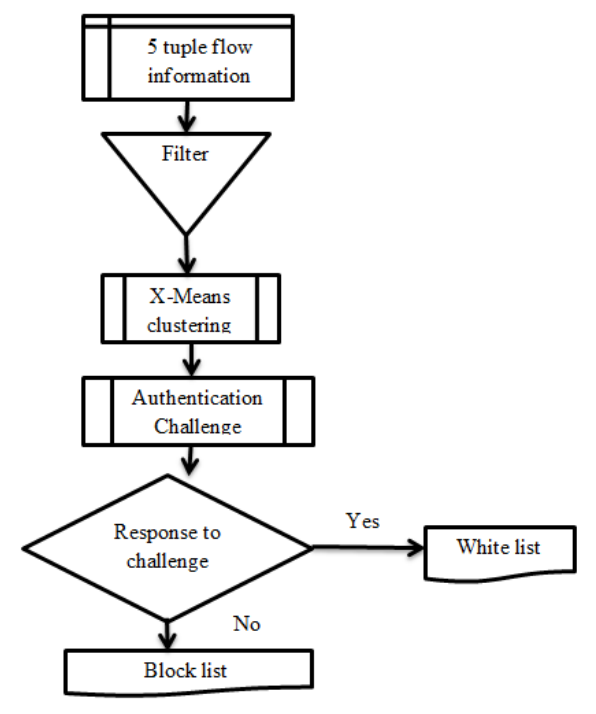
Figure 6. A hybrid threat detection